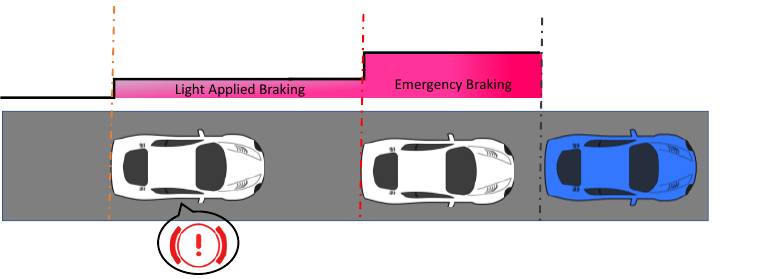
Figure 1. Overview of the AEB process [3].